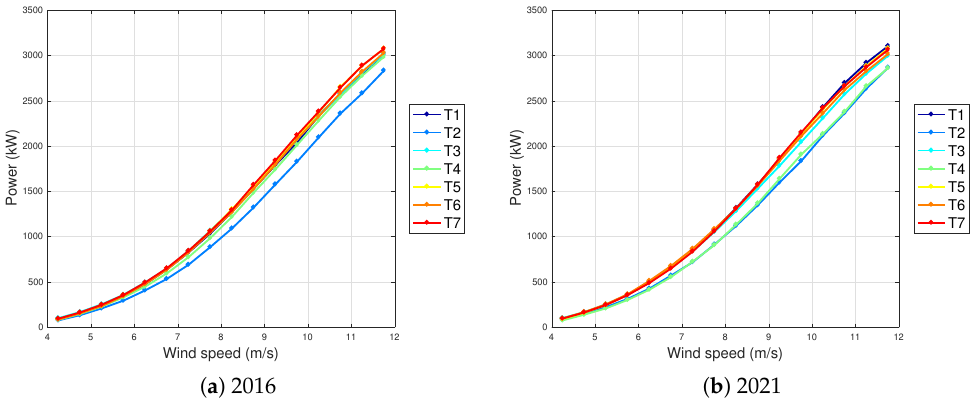
Figure 8. Power curve for the whole wind farm, computed using the binning method.